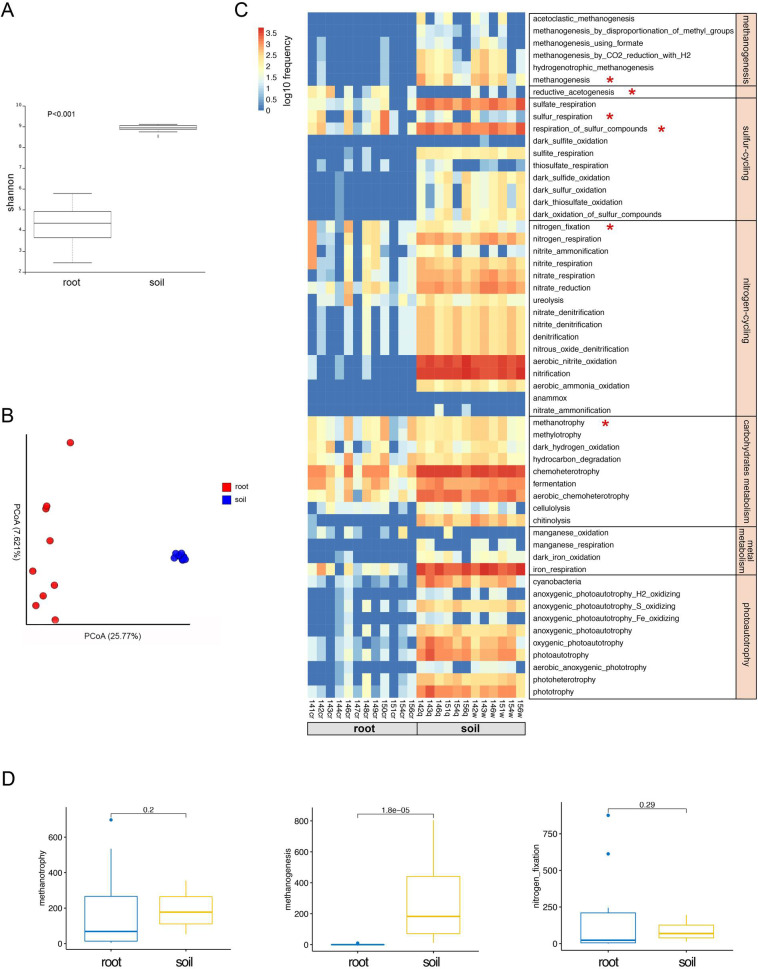
Microbiota diversity, community structure and functional analysis between the roots and bulk soil.(A) Alpha diversity estimates. (B) Beta diversity estimates. (C) ASVs involved in potential ecologically functions in roots and bulk soil. (D) ASVs involved in the potential CH4–N cycle between roots and bulk soil. Statistical significance was identified by the wilcoxon test with a false discovery rate (FDR)-corrected pairwise P values.